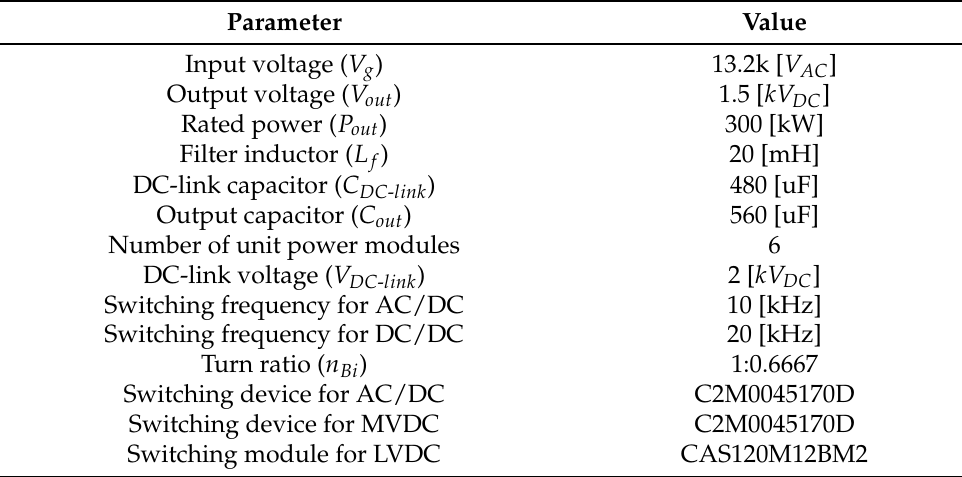
Table 3. Design specifications of a solid-state transformer